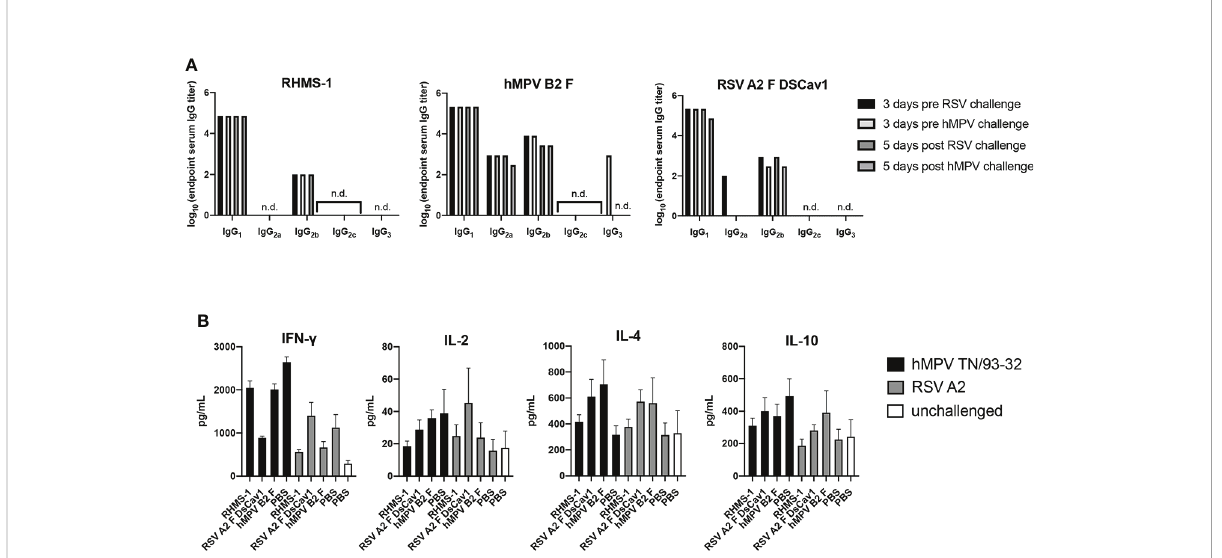
FIGURE 7 TH1/TH2 antibody and cytokine response after immunization and challenge. (A) Mouse serum IgG isotype ELISA against each vaccinating antigen (RHMS-1, hMPV B2 F, RSV A2 DsCav1) three days prior to viral challenge and fi ve days post-challenge (hMPV TN/93-32, RSV A2). n.d., no detection above OD405 = 0.3. (B) Cytokine ELISA in the lung homogenates of mice fi ve days post-challenge (hMPV TN/93-32, RSV A2). Error bars are the standard